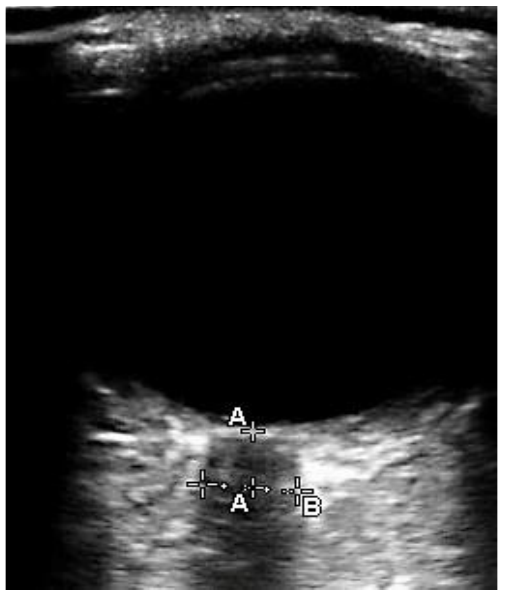
Figure 1. Ultrasonography image of optic nerve sheath. Optic nerve sheath diameter ( B : 4.7 mm) is measured 3 mm behind the optic disc ( A ).